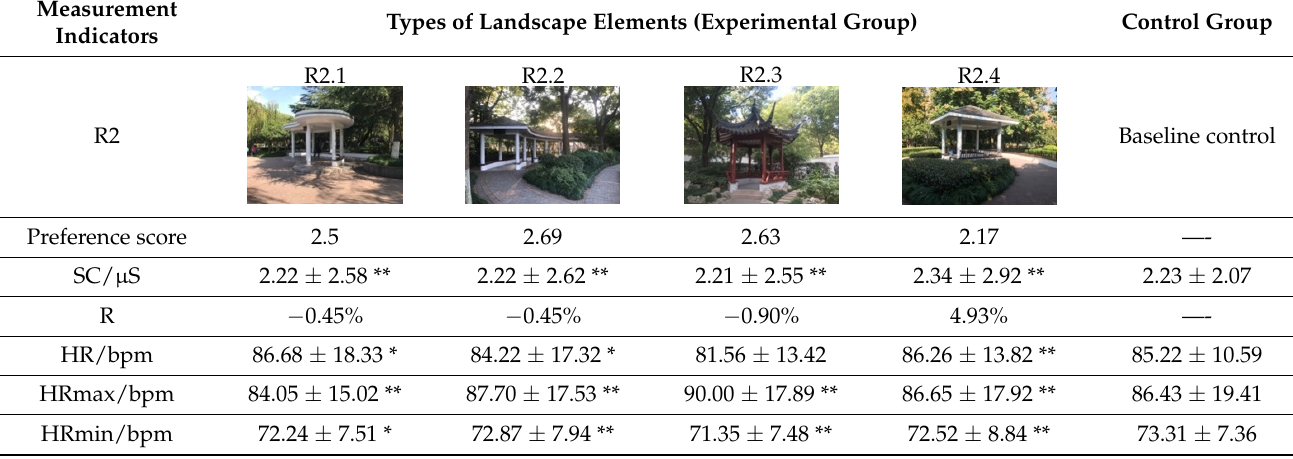
The data in the table are shown as mean ± standard deviation. * Indicates significance at a level of p < 0.05. ** Indicates significance at a level of p < 0.01.